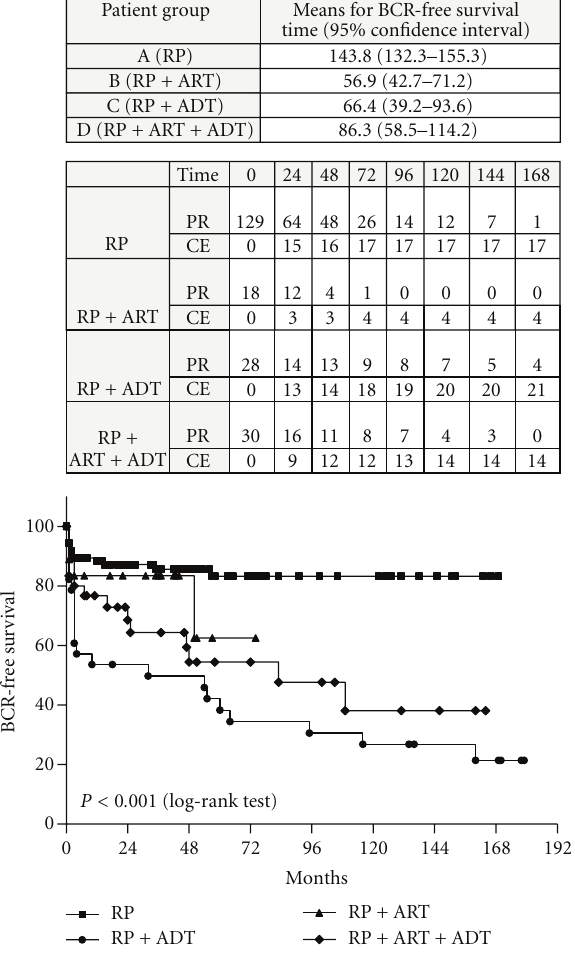
Figure 3: Kaplan-Meyer curves distribution: comparison between patients treated by RP only versus RP plus ART versus RP plus ADT versus RP plus ART plus ADT with regard to BCR-free survival rates. PR: patients at risk; CE: cumulative number of